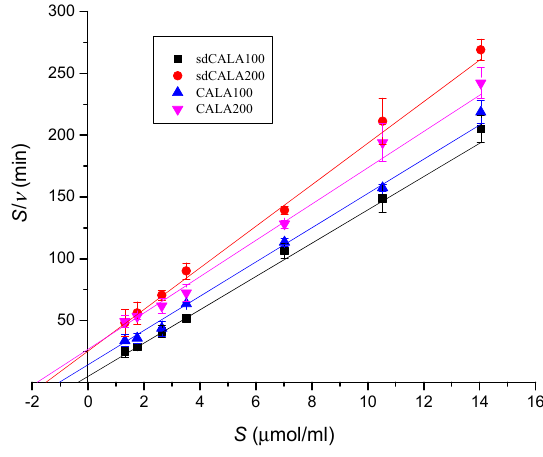
Figure 6. Hanes–Woolf diagram for CALA and sdCALA. Table 3. Kinetics parameters of CALA and sdCALA.